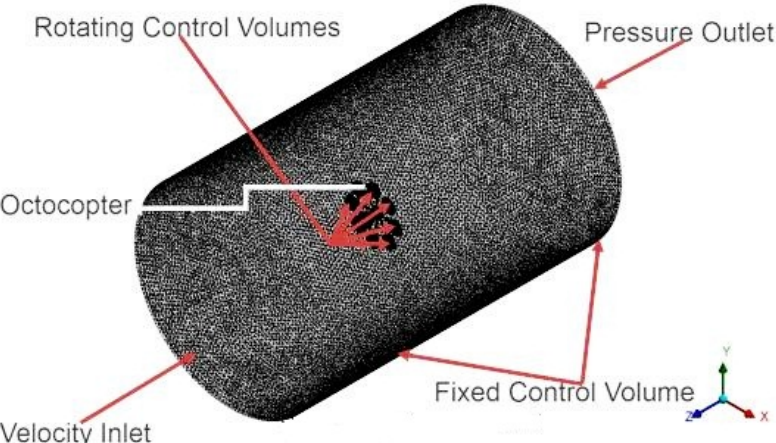
Figure 20. Integrated FVM modeled control volume with the component names.